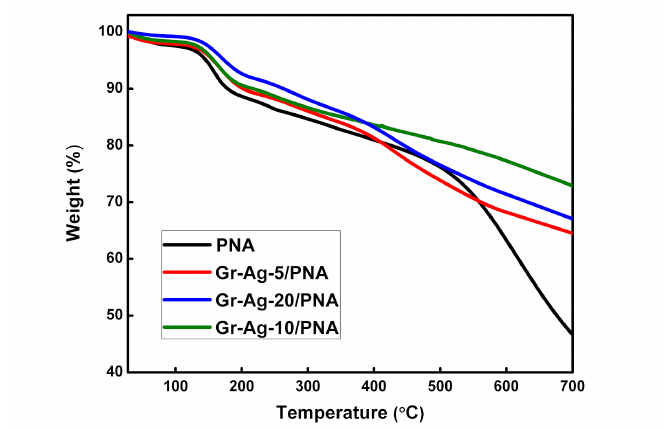
Fig. 3. TGA profile of PNA (a), Gr-Ag-5/PNA(b) Gr-Ag-10/ PNA(c) and Gr-Ag-20/PNA(d)